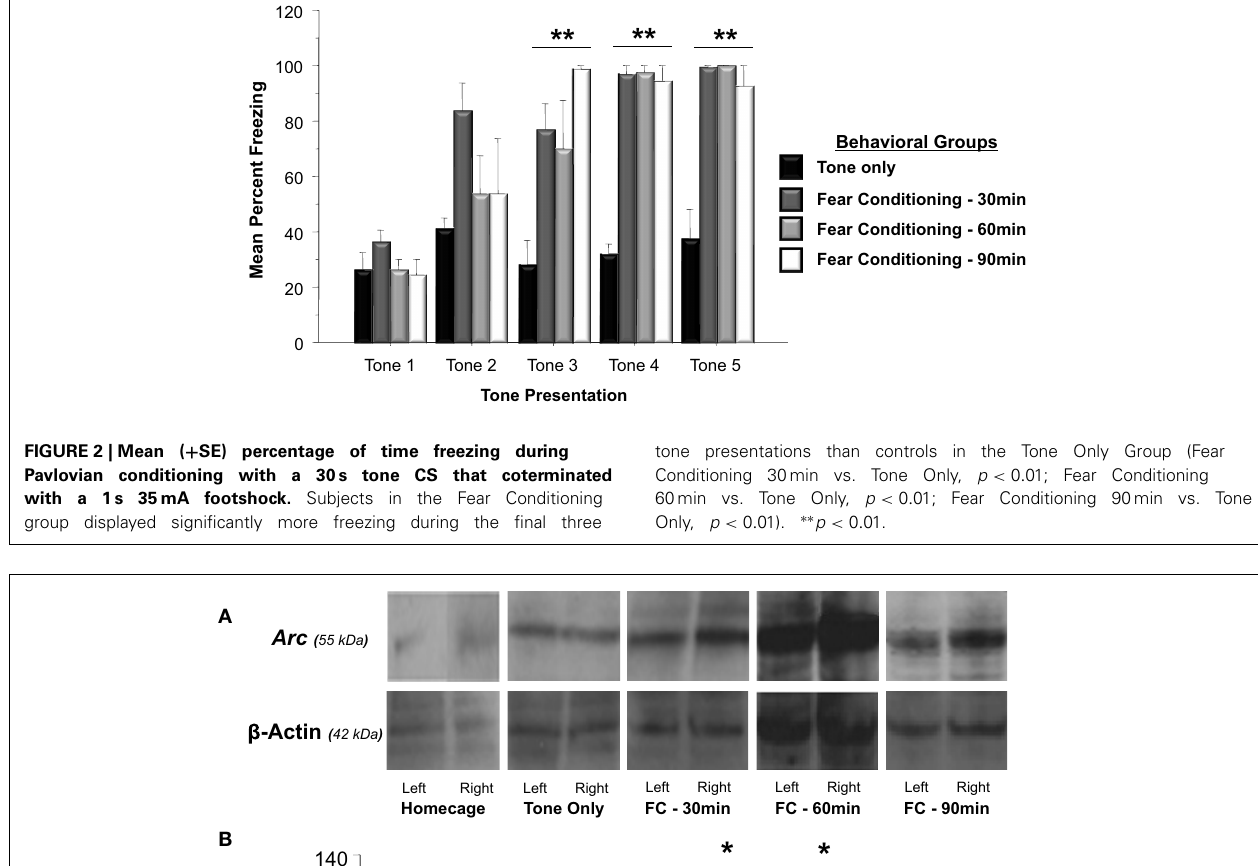
FIGURE 3 | (A) Western blot analysis of left and right amygdala homogenates of Homecage controls, Tone only controls and animals that received Pavlovian fear conditioning with five tone-shock pairings 30, 60, or 90min prior to sacrifice and brain extraction. (B) Western blot quantification of Arc expression in the left and right amygdala of the three groups described in (A) . Fear conditioning produced a significant increase in Arc expression relative to the change produced by resting in the homecage or following tone